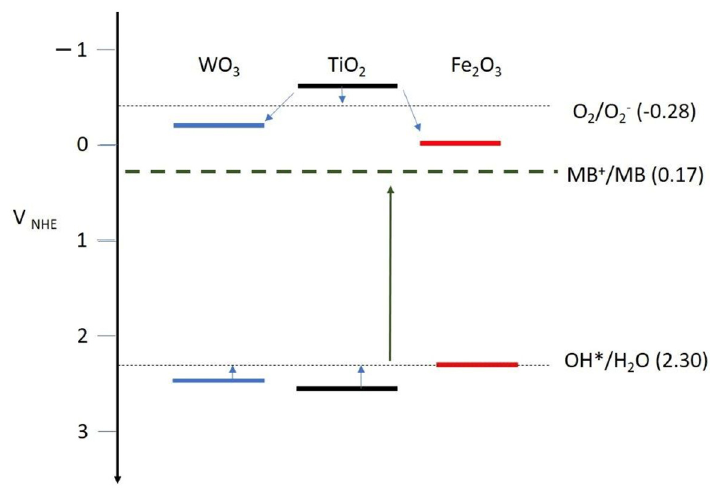
Figure 6. TiO 2 , Fe 2 O 3 , and WO 3 band energy